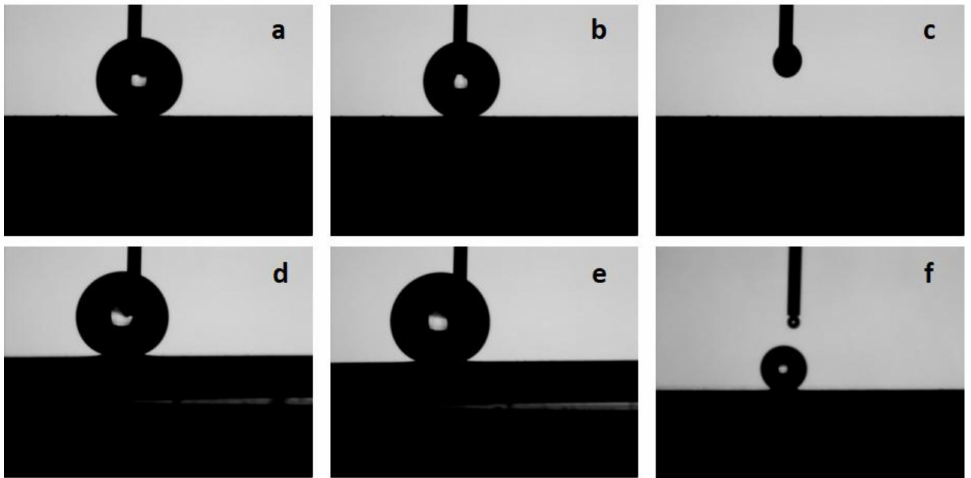
Figure 4. Typical snapshots of the water droplets obtained in the determination of advancing and receding contact angle (CA): ( a ) and ( d ) expanding droplets, ( b ) and ( e ) contracting droplets, and ( c ) and ( d ) wetting as water recedes into the syringe for ( a – c ) PFDPA@TNTA and ( d – f ) ODPA@TNTA